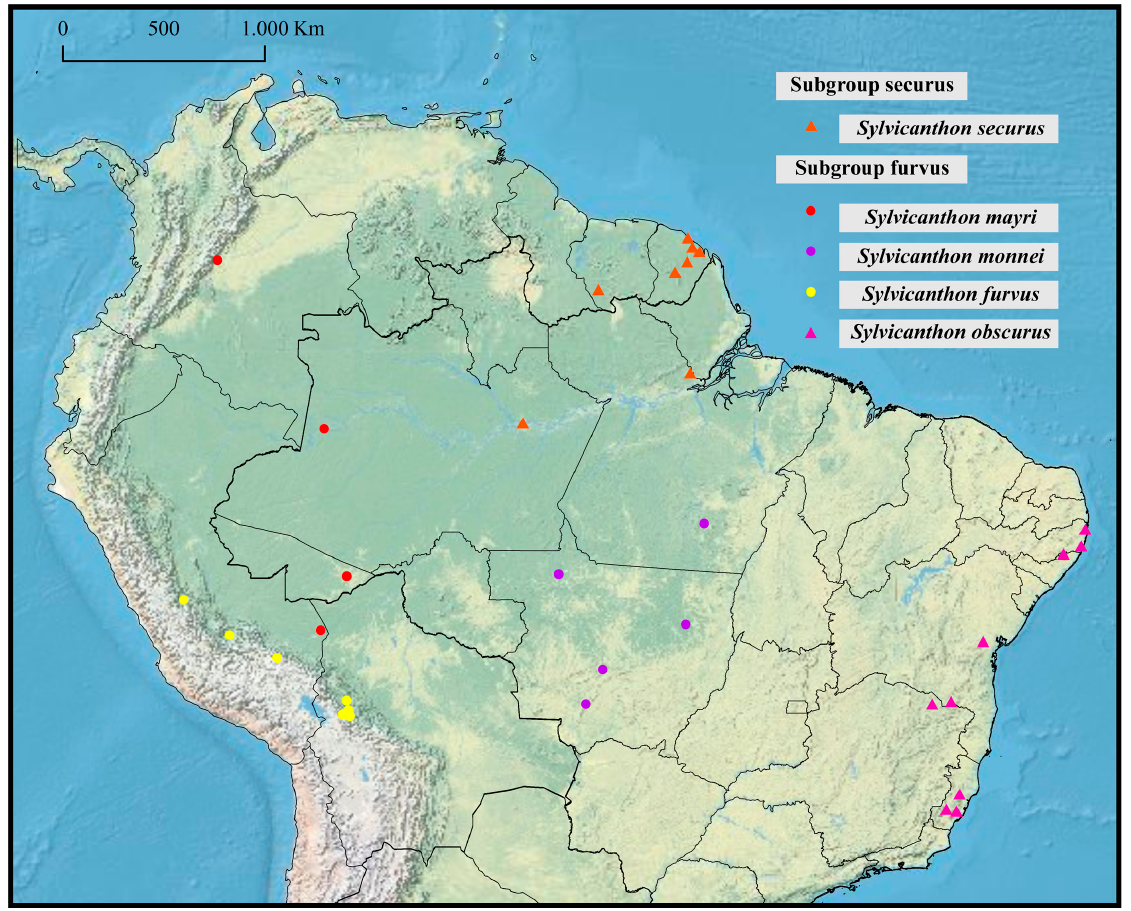
Fig. 41. Distribution of Sylvicanthon securus (Schmidt, 1920) comb. nov. and the four species of the furvus